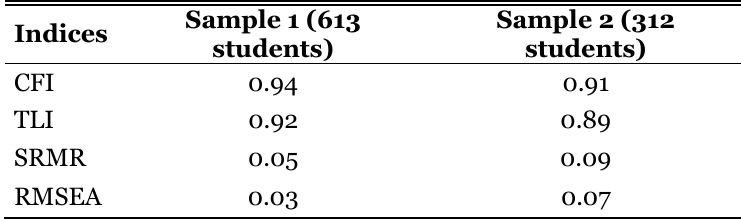
Results of the Confirmatory Factor